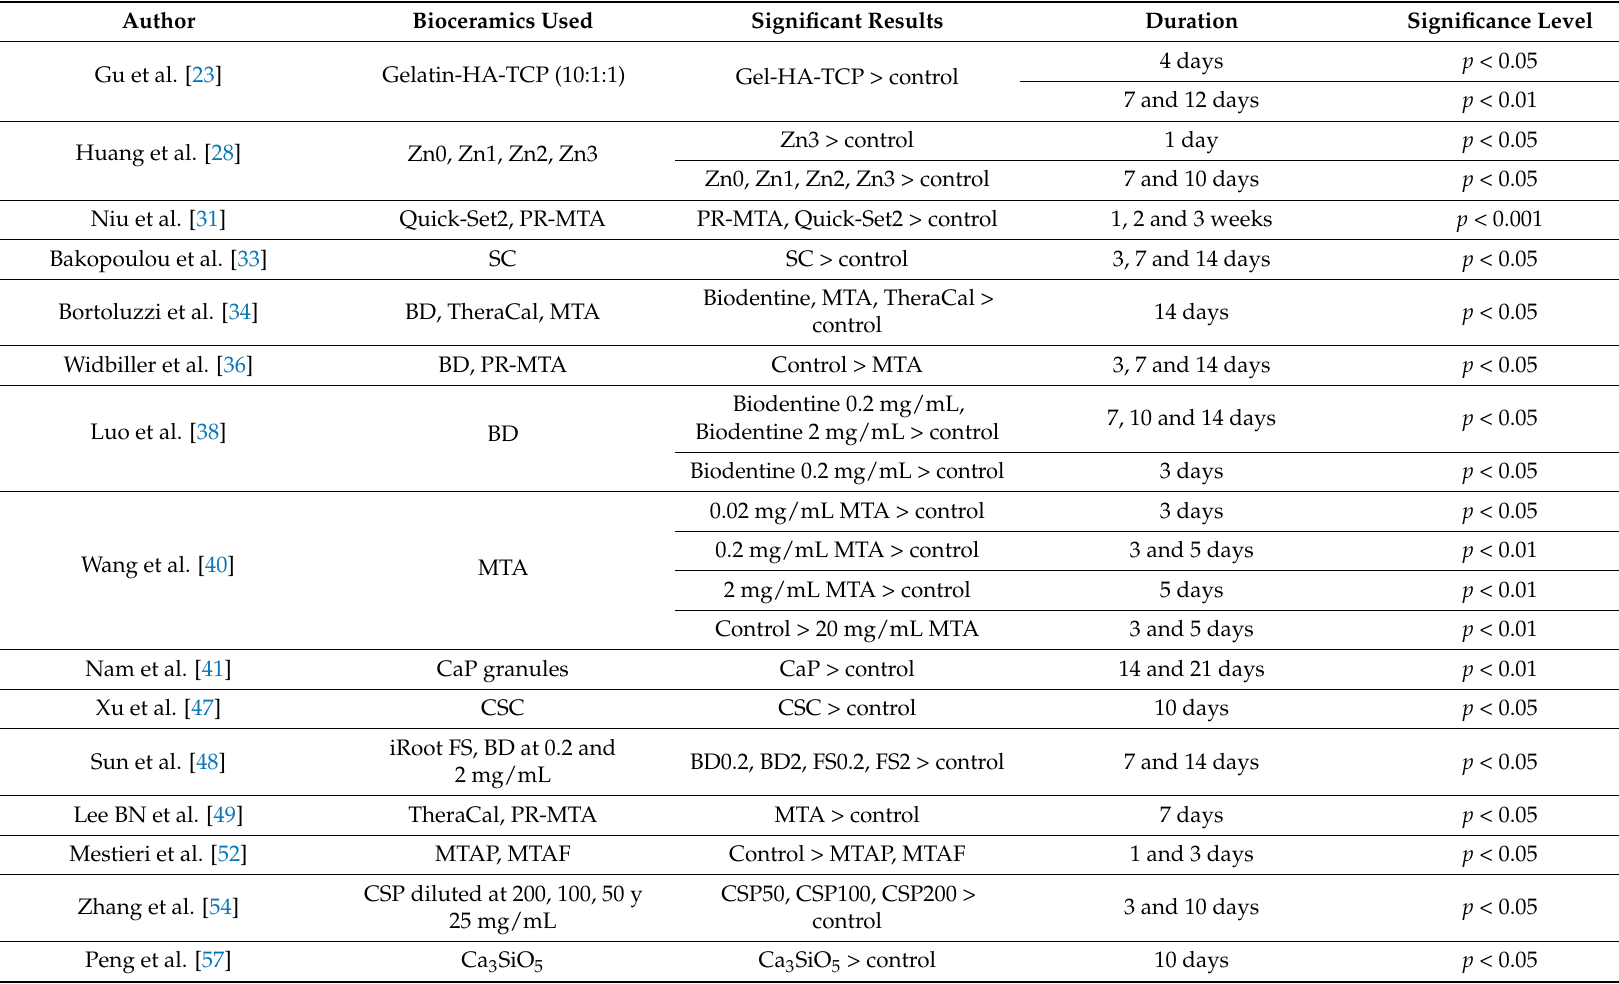
Table 16. Summary of the results of included studies showing significant differences between a bioceramic material and a control for ALP